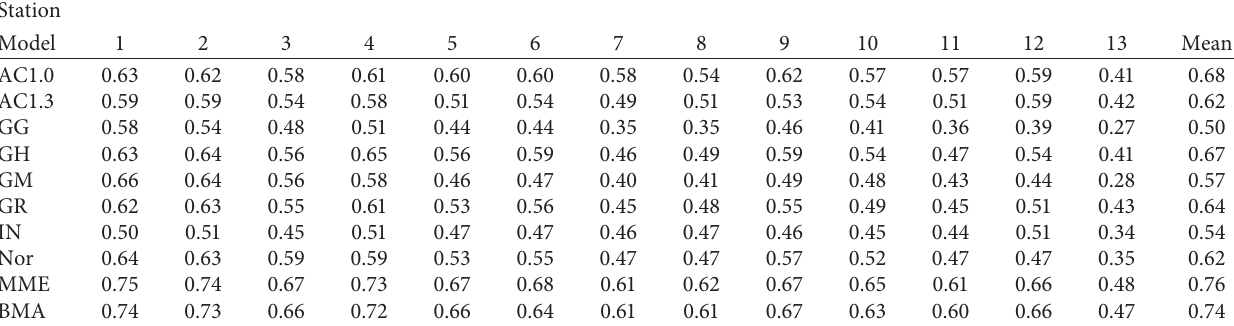
Table 5: The PCC between the monthly observed precipitation and the simulation performance of individual GCMs, MME, and BMA simulation in the period of 1961–2005.